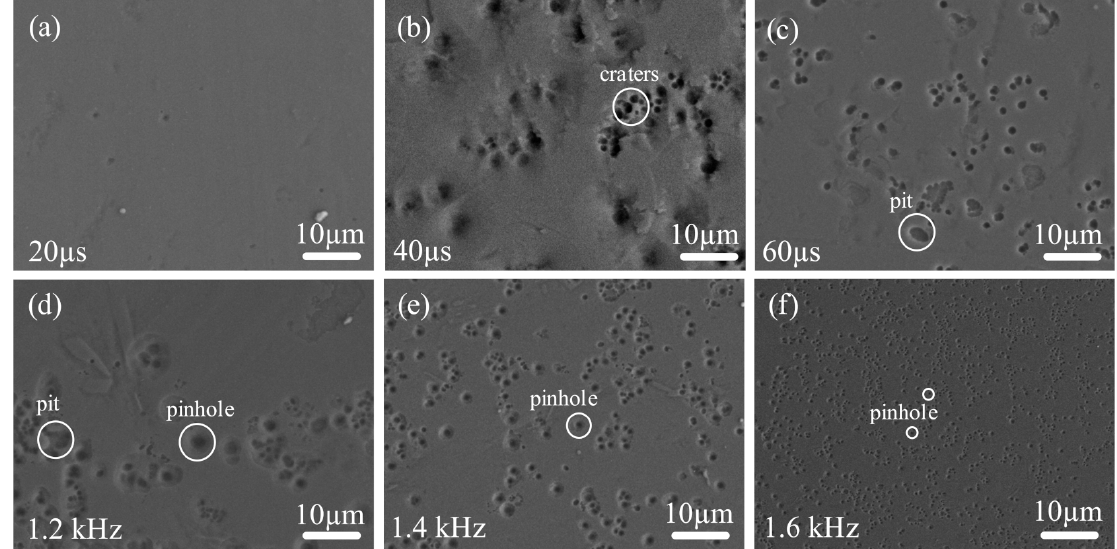
Figure 9. Surface morphology of defects on Cr 2 AlC coating surface produced during HiPIMS deposition by changing ( a – c ) pulse width, and ( d – f )